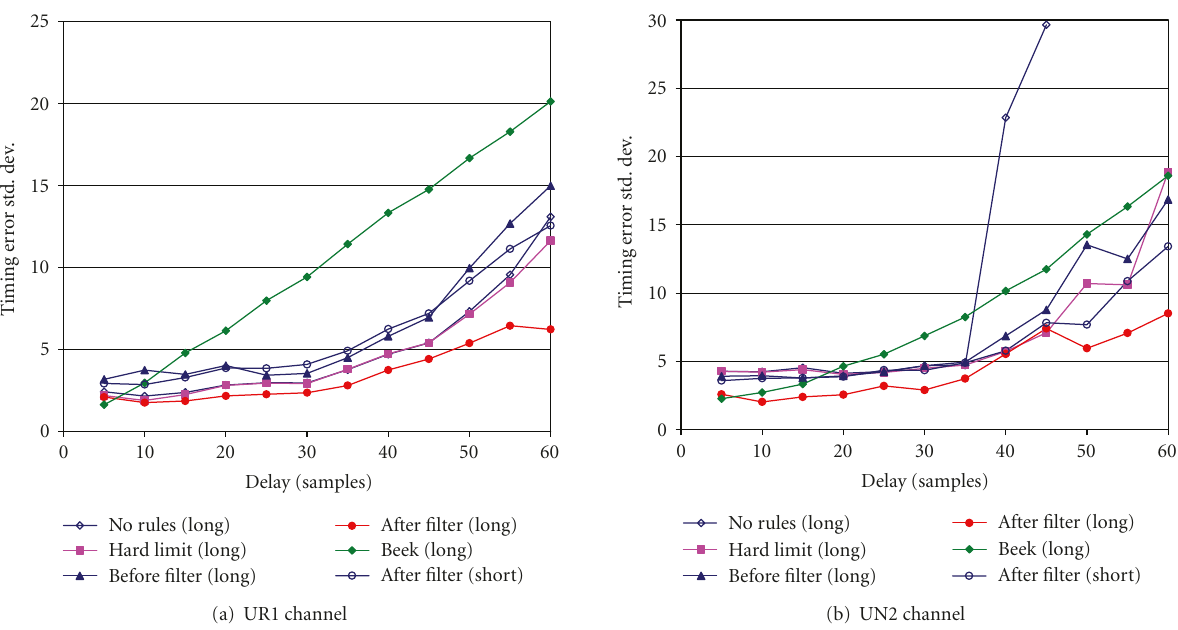
Figure 12: Performance of rule-based processing as a function of multipath cluster